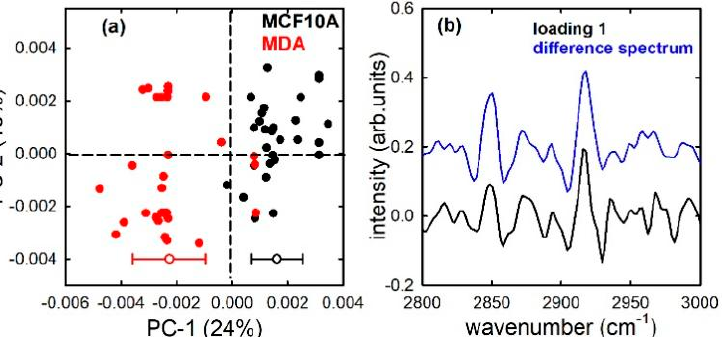
Figure 4. PC1 and PC2 score plot ( a ) for the MCF10A (black dots) and MDA (red dots) cells; average (+0.0016 and − 0.0023 for MCF10A and MDA, respectively) and standard deviation (0.0009 and 0.0013 for MCF10A and MDA, respectively) of the PC 1 distribution values are shown at the bottom of ( a ). Loading 1 spectrum (black line), compared with the difference between average spectra (blue line), is reported in ( b ).